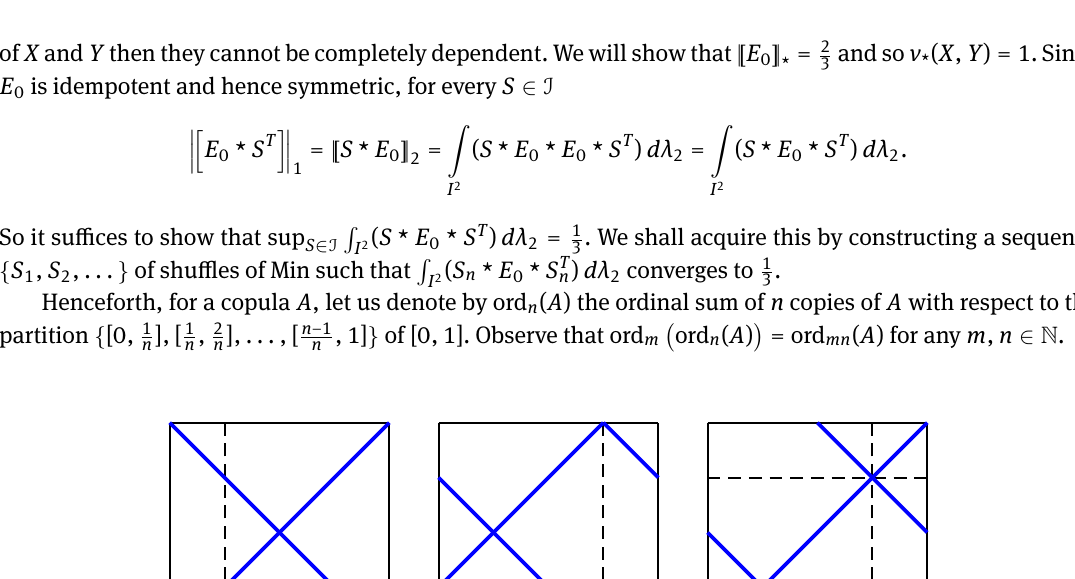
Denote S 1 (cid:17) S 3 which is the shuffle of Min supported on the main diagonals of the squares [0 , 3 , 1 4